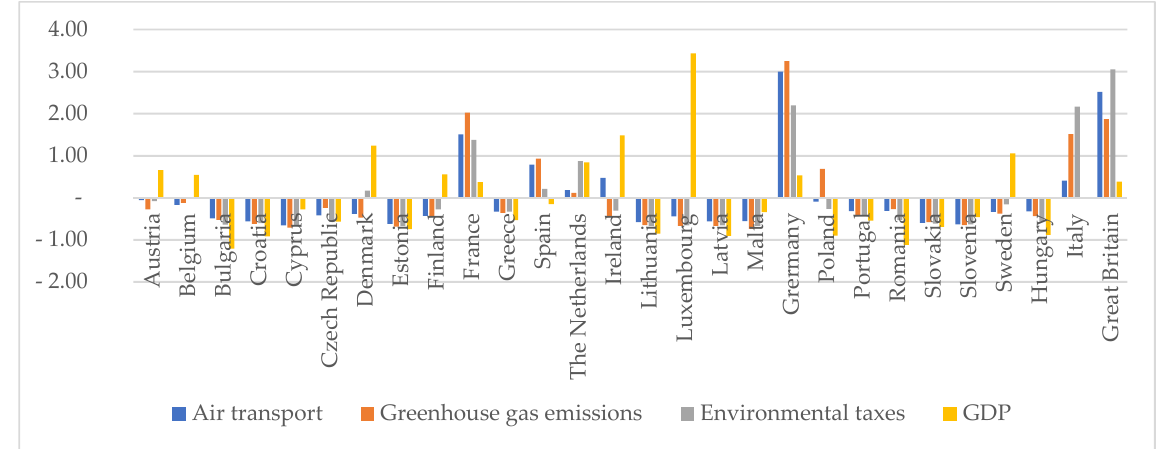
[16], Eurostat: 2009—2018.